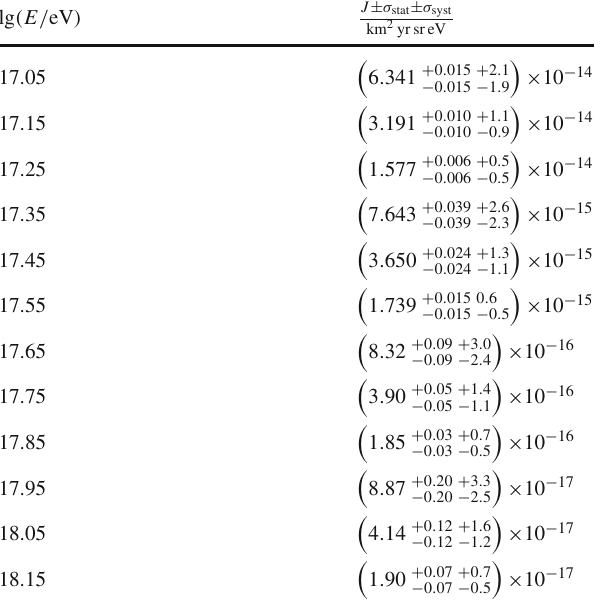
Table 10 Combined SD spectrum data. The correlations between sys- tematic uncertainties are provided in the Supplementary material lg ( E / eV